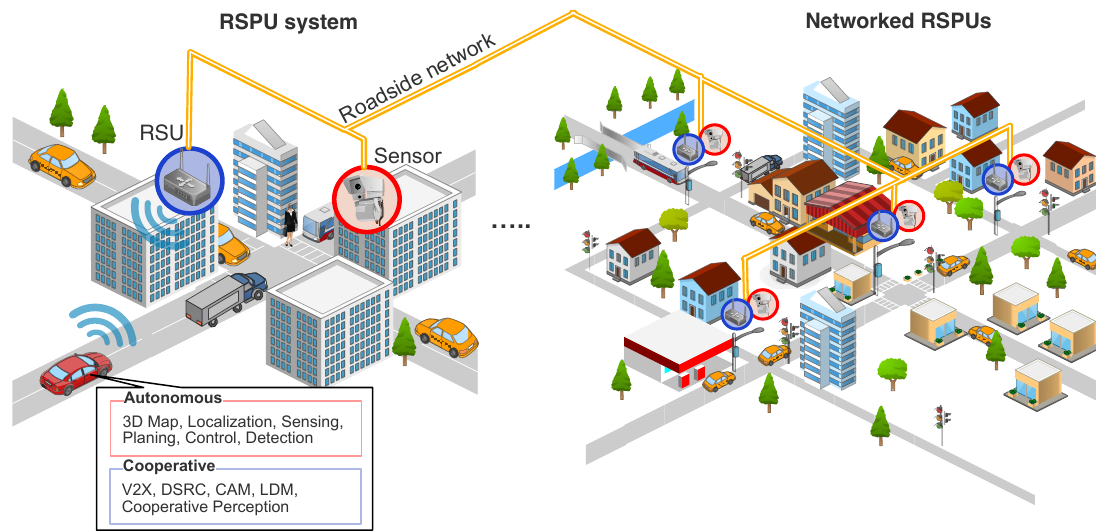
Figure 1. The roadside perception unit (RSPU) system and networked